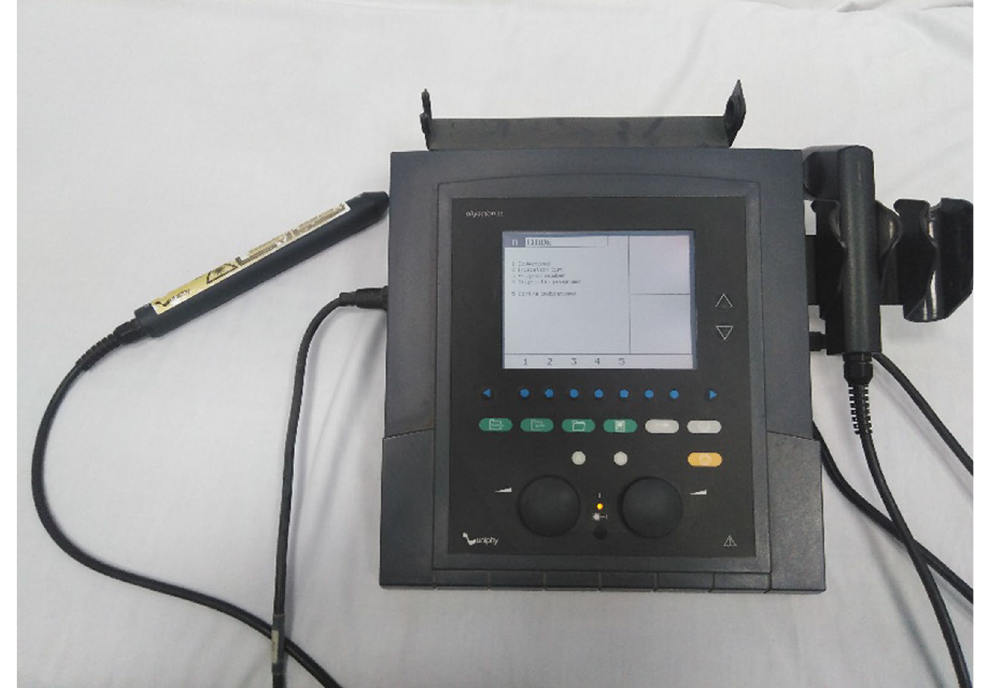
Fig. 1 Laser acupuncture machine phyaction